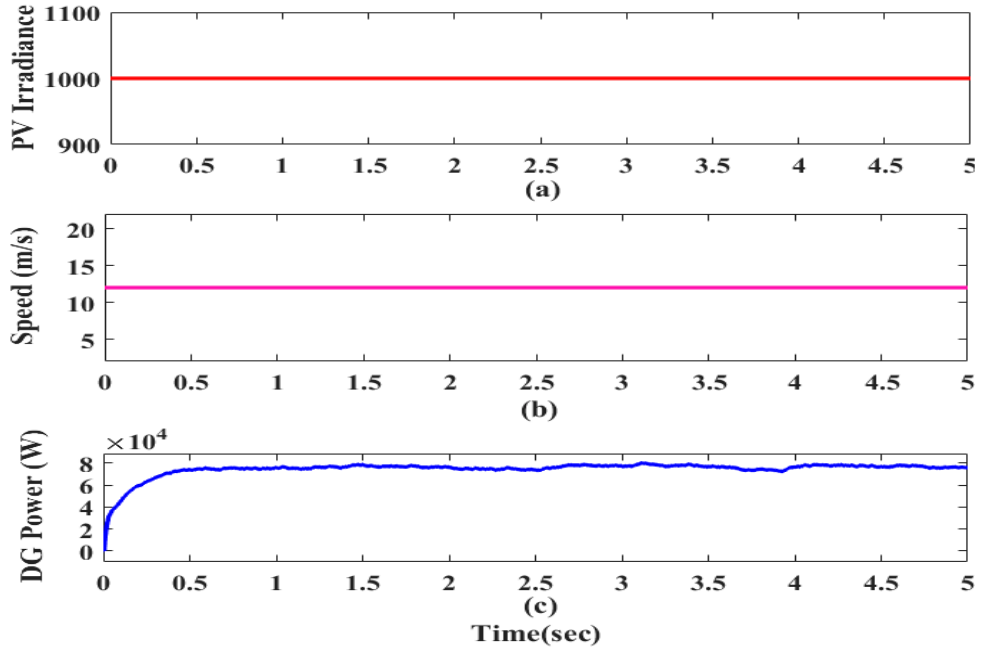
Figure 10. ( a ) Irradiance ( b ) Wind speed ( c ) DG Power. Mode II. Power Quality improvement (P Res = 0).